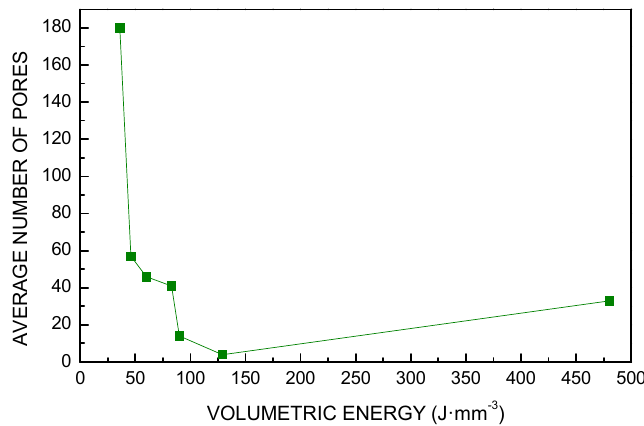
Figure 6. Number of pores as a function of VED .